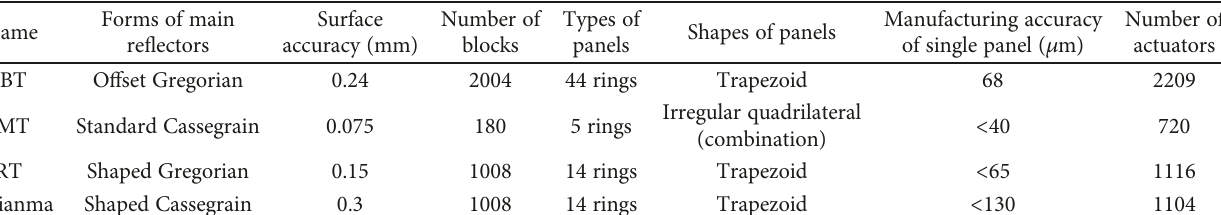
Table 4: Four radio telescopes with active main surface.